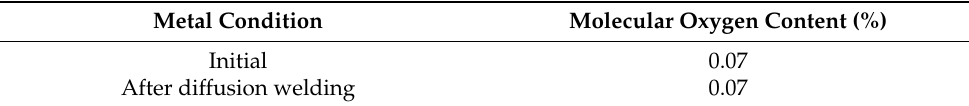
Table 14. Oxygen content in titanium alloy before and after diffusion welding.